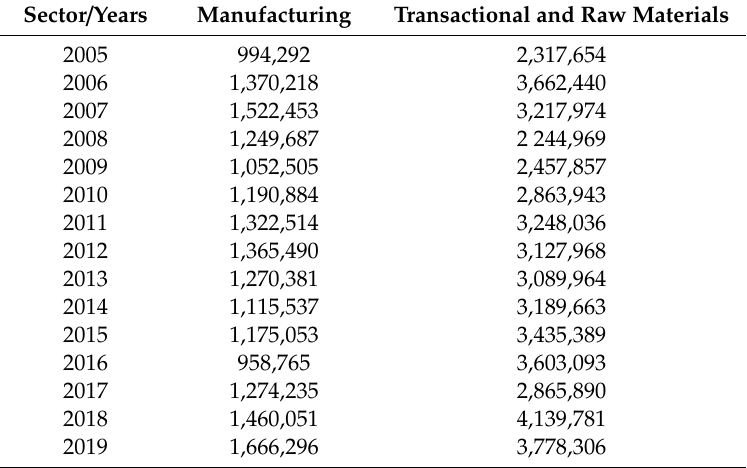
Table 2. Profit by sectors in the Russian economy, measured in 2004 rubles, million rubles 6 . Sector / Years